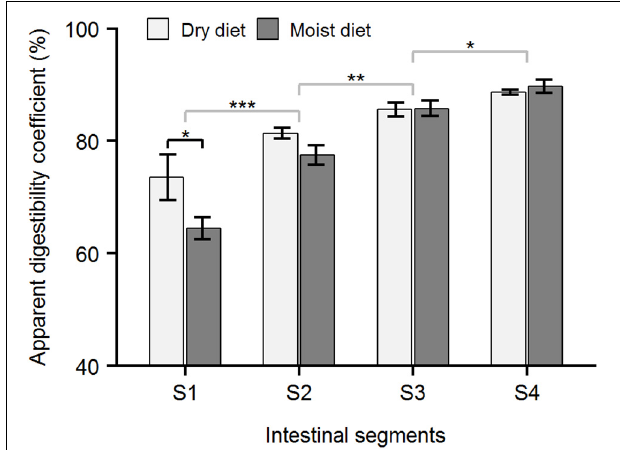
FIGURE 6 | Apparent digestibility coefficient (ADC) of protein in ballan wrasse intestine. The figure shows the ADC (%) of protein in the 4 intestinal segments (S1–S4) of fish fed with dry or moist diets. Asterisk’s ( ∗ ) above horizontal square brackets indicate significant differences (glmmPQL test in R) between treatments (black line) or between adjacent intestinal segments (gray lines). ∗∗∗ p < 0.001, ∗∗ p < 0.01, ∗ p < 0.05. Data are mean ± SEM, n = 6.